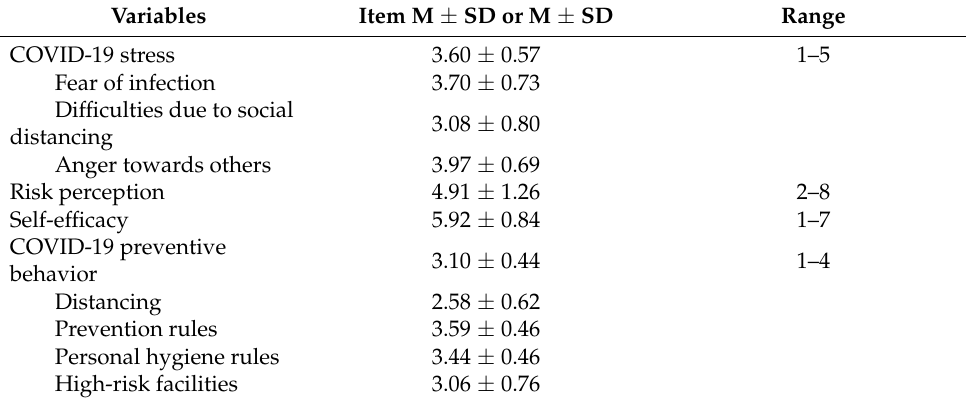
Table 2. Degrees of COVID-19 stress, risk perception, self- efficacy and COVID-19 preventive behavior.